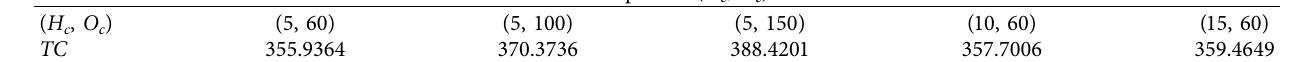
Table 1: The impact of ( H